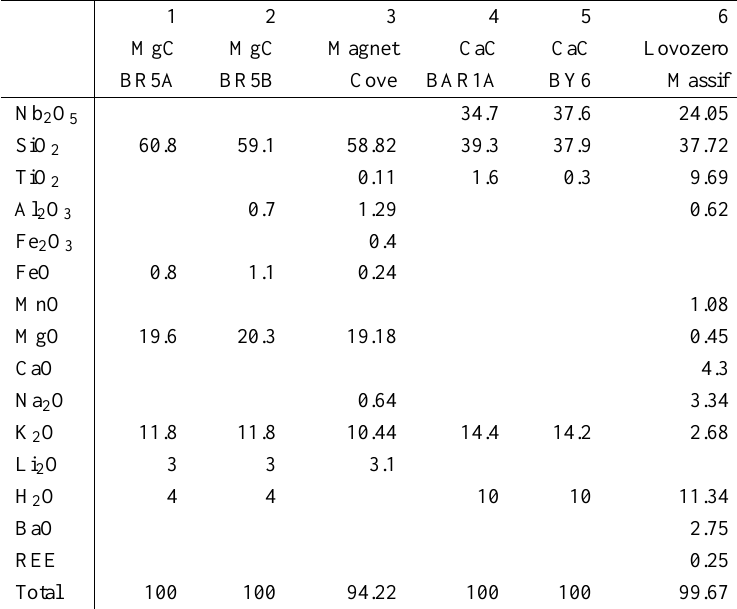
Representative tainiolite (1-2) and nenadkevikite (4-5) analyses of Araxá rocks. ForrockabbreviationsseeTableI.Forcomparison, mineralanalyses from Magnet Cove and Lovozero rocks,